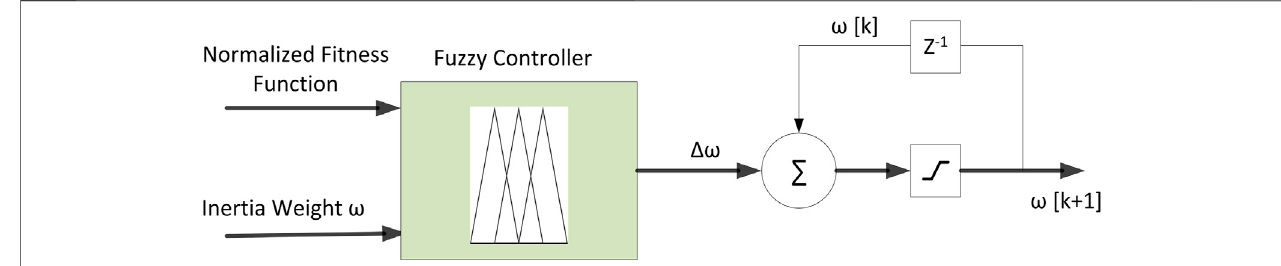
FIGURE 4 | Block diagram of fuzzy